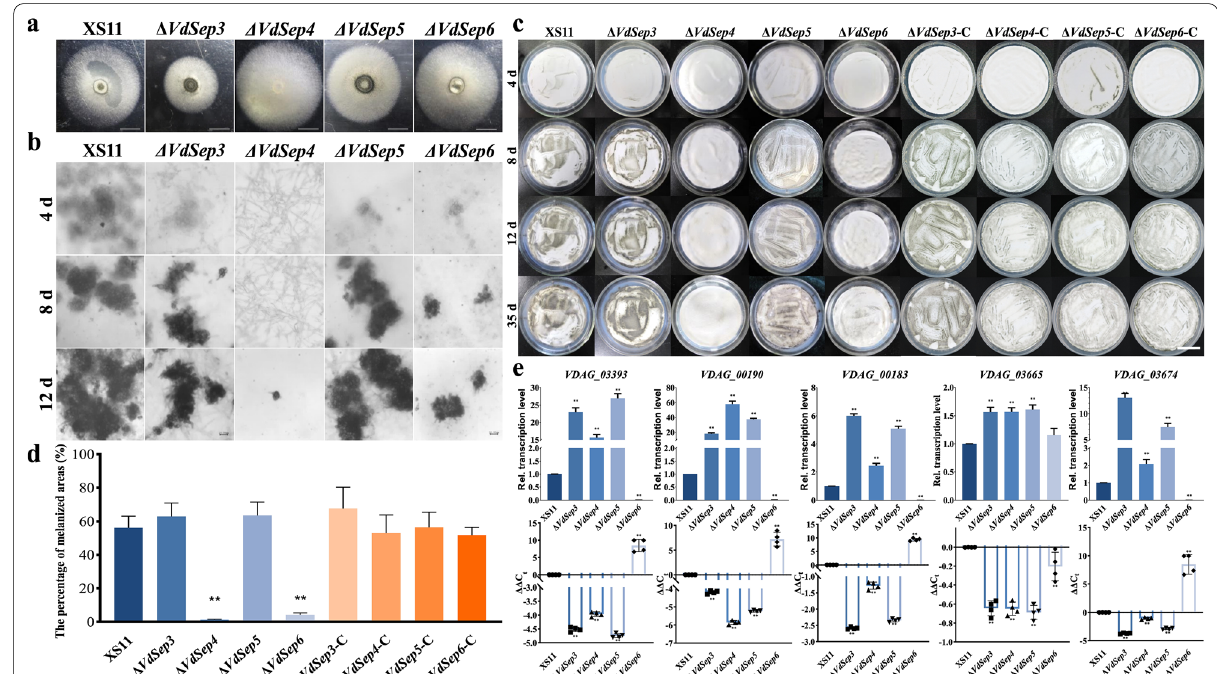
Fig. 1 Septins regulate the formation of melanized microsclerotia. a Colony phenotype of the wild-type strain XS11 and mutants (Δ VdSep3 , Δ VdSep4 , Δ VdSep5, and Δ VdSep6 ) on complete medium (CM). Conidial suspension (10 6 conidia/mL) of each strain was dropped onto a glass slide covered with CM and incubated at 25 °C for 5 days. Bar 0.28 cm. b Microscopic observation of microsclerotial development at 4, 8, and 12 days = of incubation. Bar 20 μm. c Colony phenotype of the indicated strains on nitrocellulose membrane overlayed on basal medium (BM). Conidial = suspension (10 6 conidia/mL) of each strain was dropped onto the membrane and incubated at 25 °C. Bar 3 cm. d Melanized areas of the colonies = were determined using ImageJ at 35 days of incubation. Error bars represent standard deviations based on three independent replicates. Asterisks indicate significant differences (**, P < 0.01). e Evaluation of relative expression levels of the genes involved in melanin synthesis in V. dahliae via RT-qPCR. The average gene expression values were normalized against the V. dahliae β-tubulin gene. Error bars represent standard deviation based on four independent technical replicates, and the determined ΔΔCt values were shown in the bottom panel (**, P <